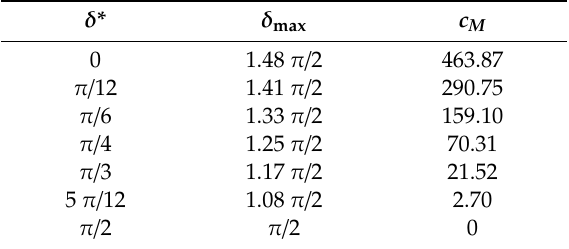
Table 2. The calculated constants δ max and c M for di ff erent δ ∗ .